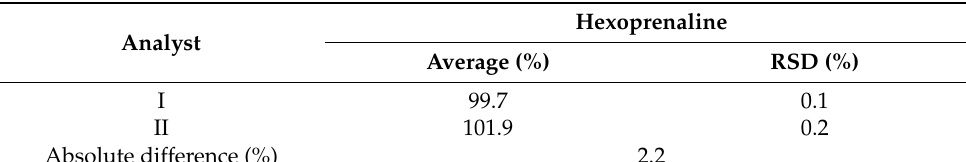
Table 6. Precision results from method validation.